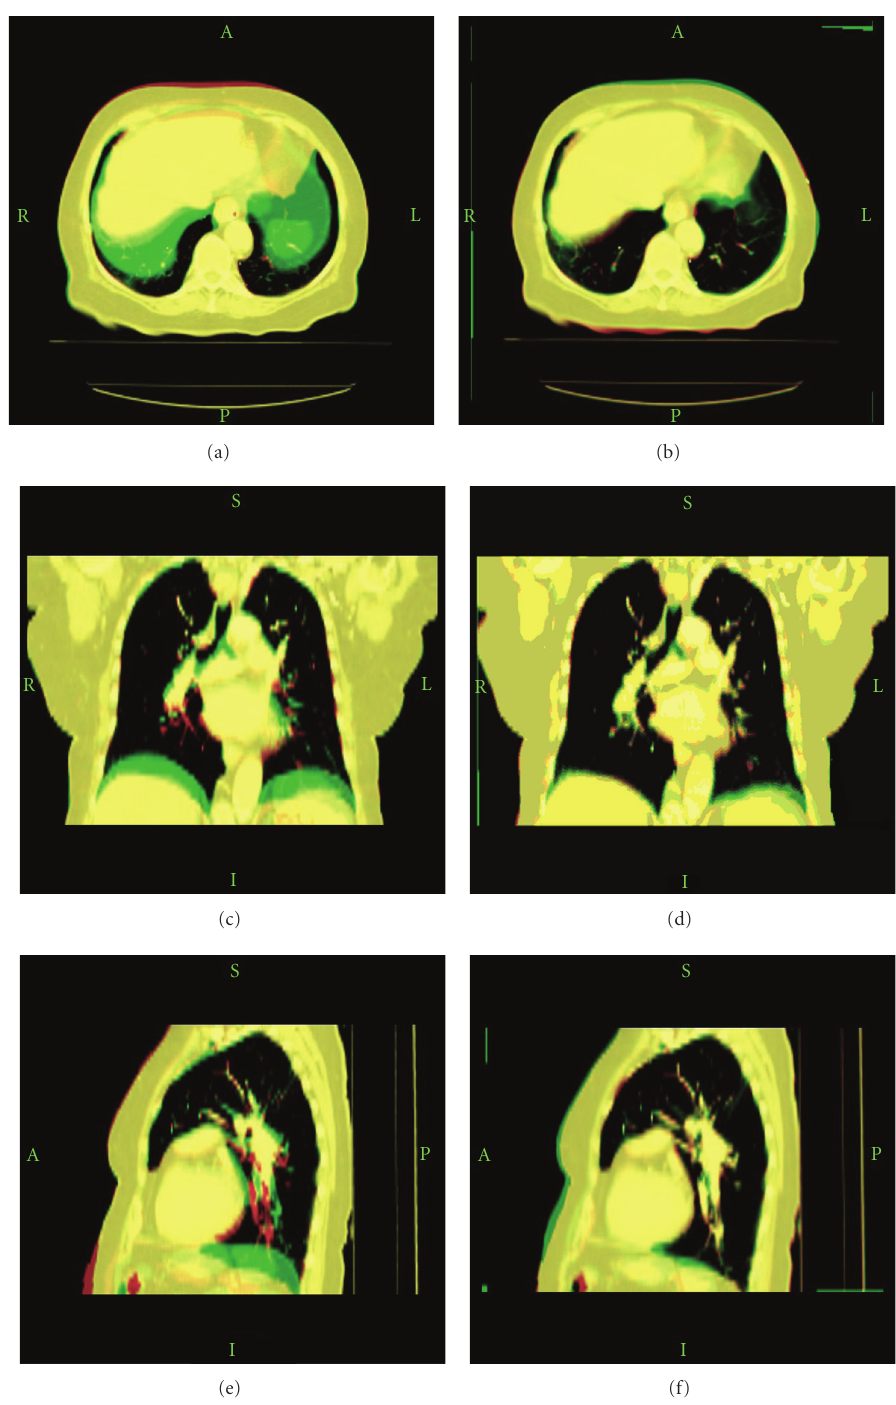
Figure 6: Image registration results of 4D CT